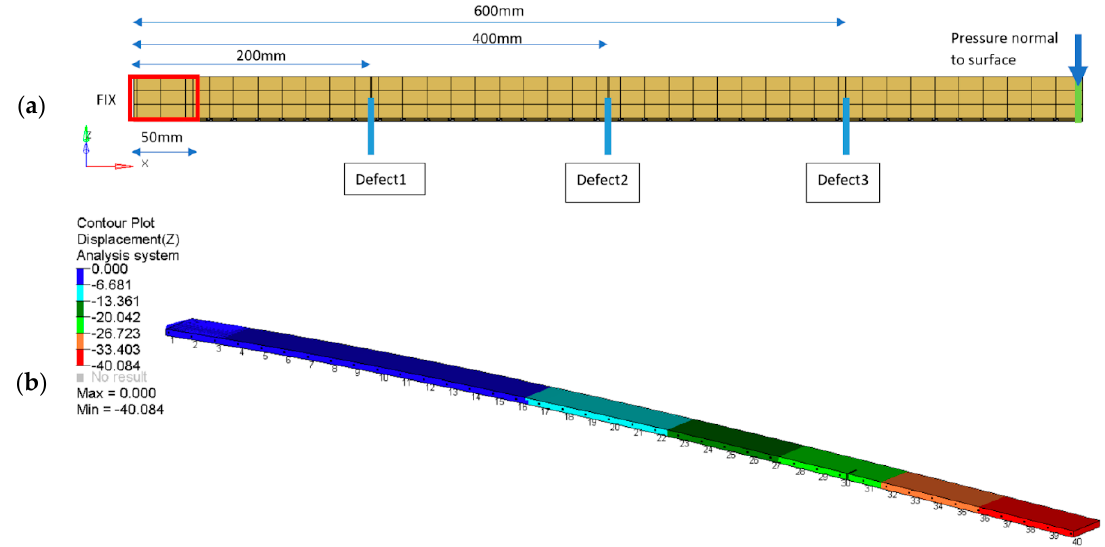
Figure 11. Analyzed beam structure: model scheme ( a ) and results of the beam deflection under load ( b ).